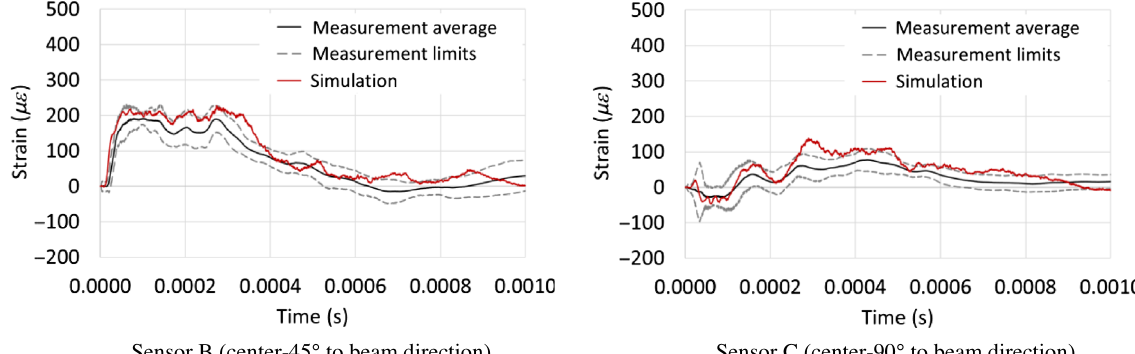
FIG. 12. Dynamic strain responses at the front center of the target in 45° (a) and 90° (b) to beam direction.